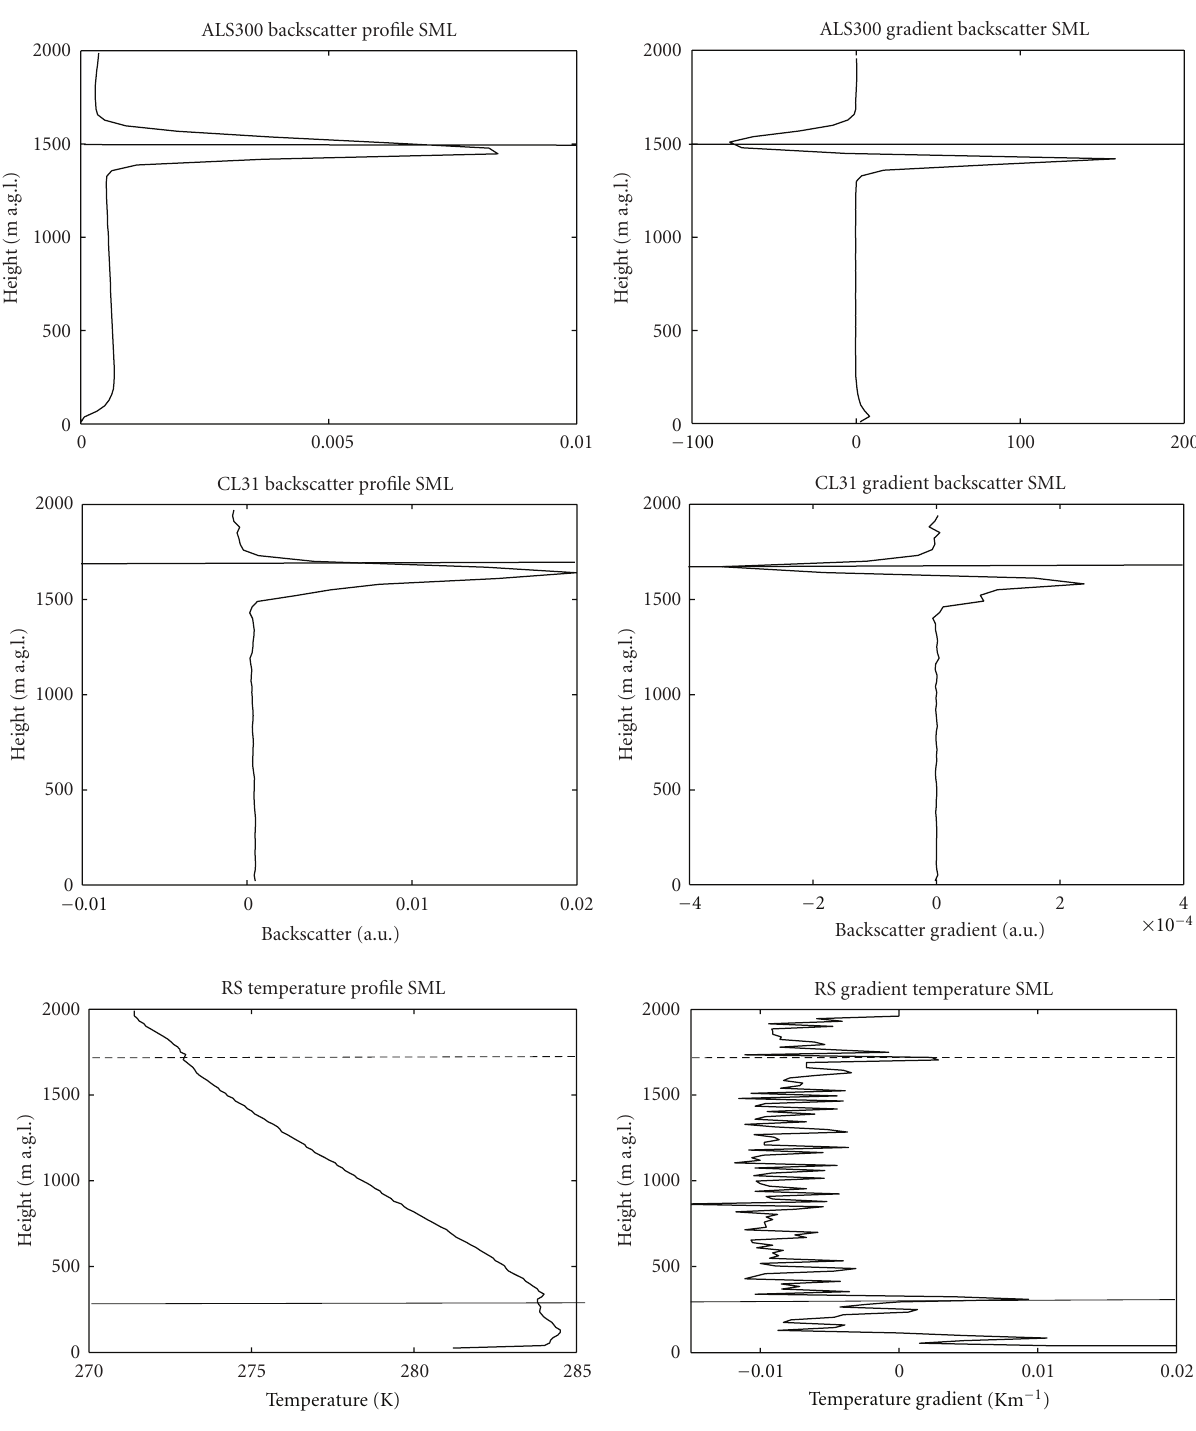
Figure 9: CL31-RS and ALS300-RS on 9 June 2009, 0515 UTC. Top and middle left, 10-minute averaged backscatter profile; top and middle right, log gradient of backscatter profiles; bottom left, temperature profile; bottom right, vertical gradient of temperature profile. Horizontal dashed and solid lines represent DRCL and SML detection,